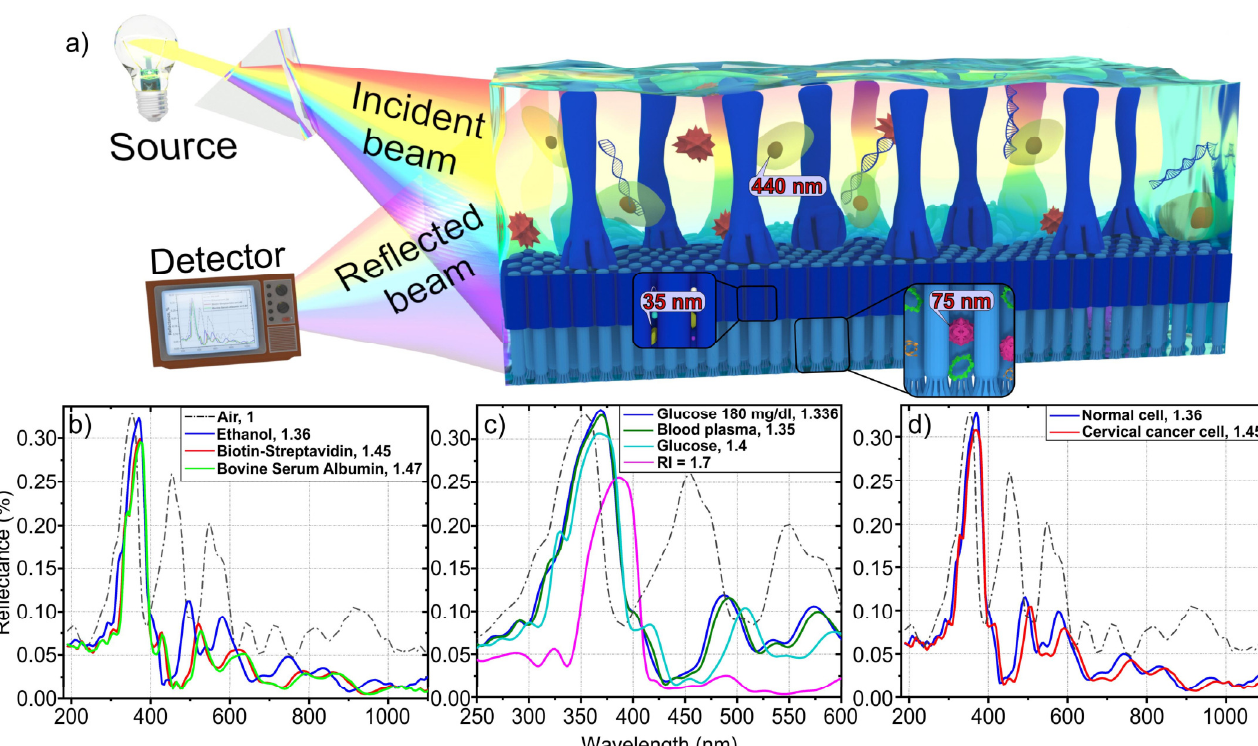
Figure 9. ( a ) 3D schematic view of the two-level column-like 3D anodic nanofilms biosensor. Re- flectance responses of ( b ) biotin-streptavidin, bovin serum albumin components in blood, and ethanol; ( c ) different glucose concentrations in blood and blood plasma; ( d ) normal cell and cervical cancer cell. The legend shows the refractive index of the respective biomedical solutions.